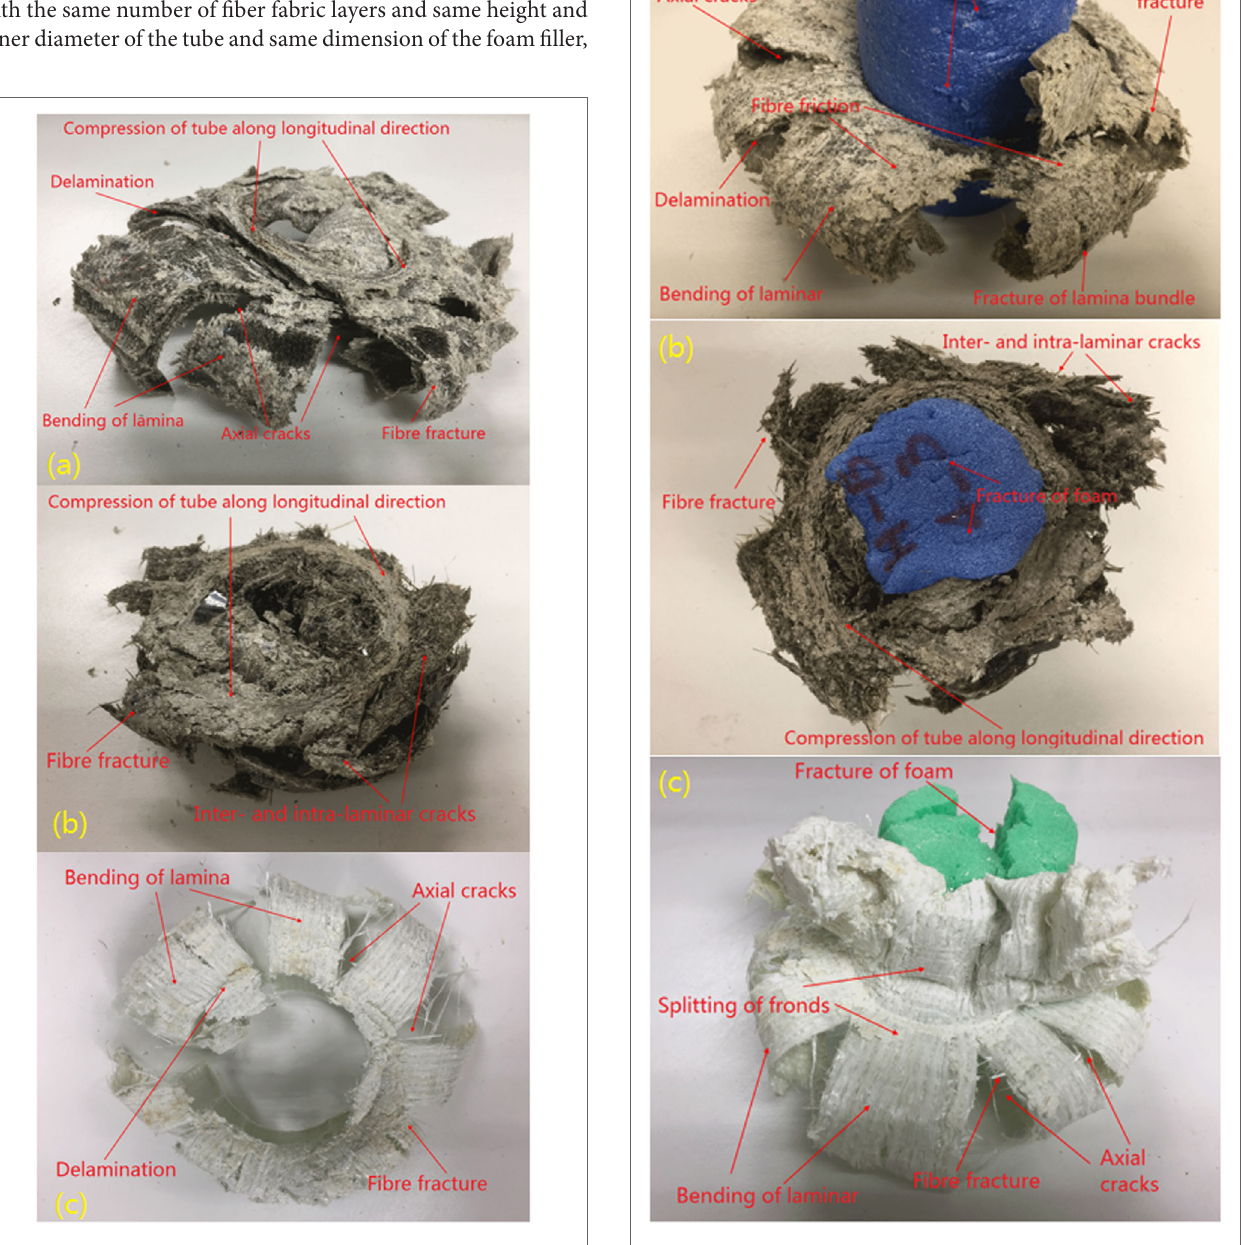
FigUre 13 | Typical failure modes of foam-filled fiber reinforced polymer tubes: (a) flax, (B) basalt, and (c)